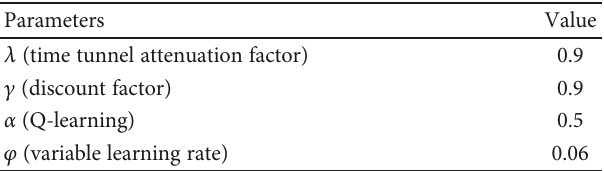
Table 1: Parameter values of EPCC.